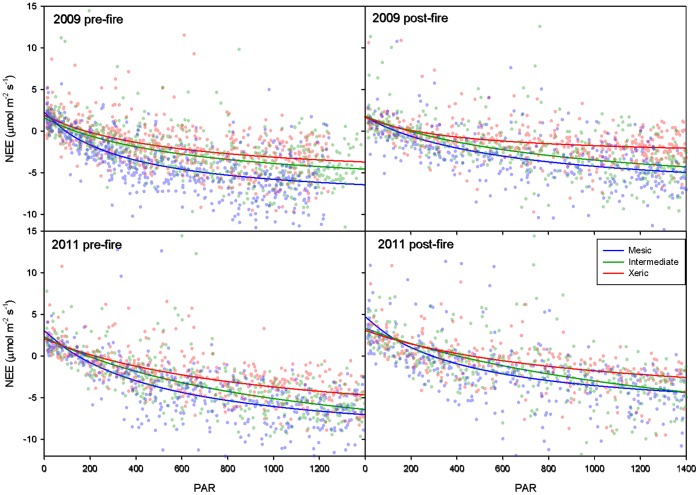
Representative pre- and post-fire light response curves.Representative light response curves pre- (left) and post-fire (right) in January 2009 (top) and March 2011 (bottom) at the xeric, intermediate and mesic sites (green, red and blue, respectively).